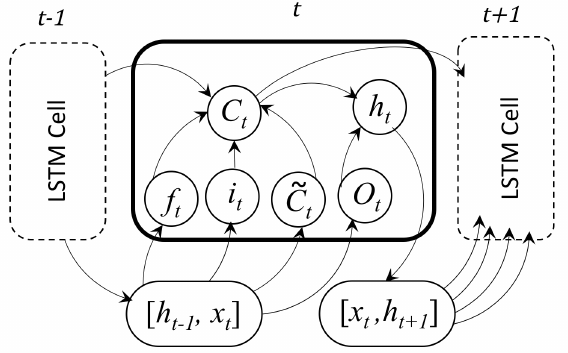
Figure 12. A long short term memory (LSTM) cell